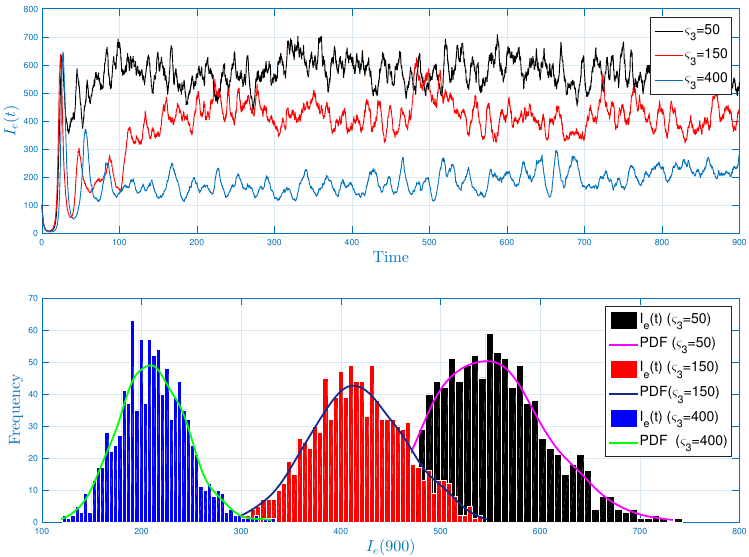
Figure 7. The first row represents the paths of the affected category for the following different time lags ς 1 = 50, ς 1 = 150 and ς 1 = 400. The second row shows the associated histograms and the probability density functions for I s